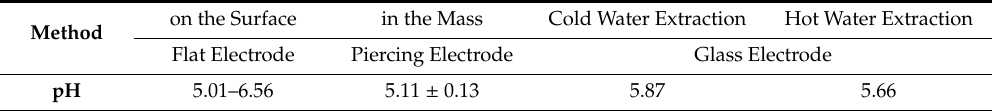
Table 4. Measured values of pH of beech